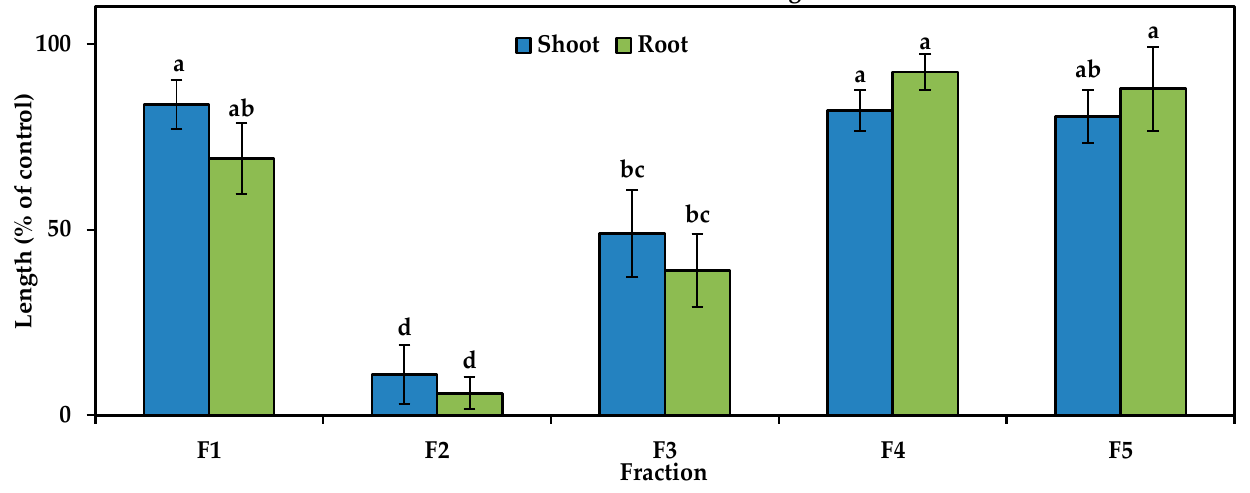
Figure 5. Allelopathic activity against cress growth of the different fractions of the A. procera extracts obtained from the column of Sephadex LH-20. The tested species was treated with the concentration of 11.2500 mg/mL. The vertical bars on the treatments indicate mean ± SE with three replications ( n = 60). Significant variations between the control and different treatments are represented by different letters (according to Tukey’s HSD test at the 0.05 level of probability).